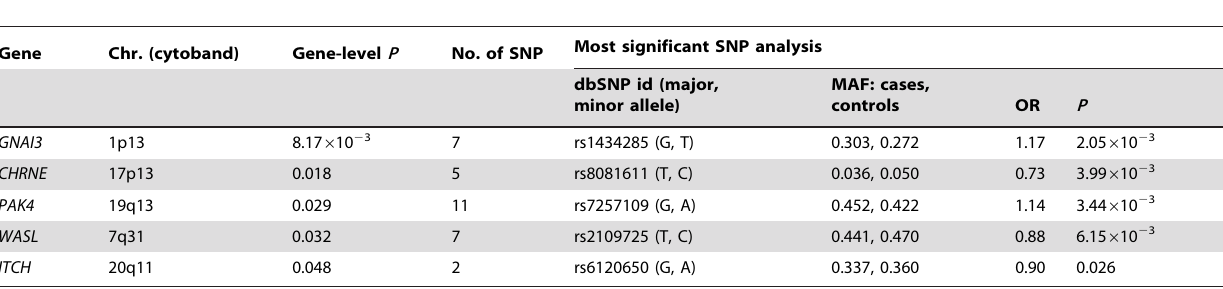
Table 1. Epidermal growth factor receptor pathway genes significantly associated with risk of esophageal squamous cell carcinoma *